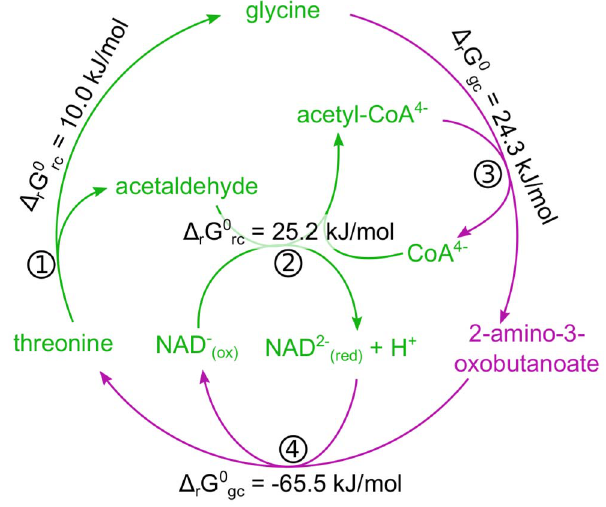
Figure 2. An example of a futile cycle where Gibbs energies are derived using RC and GC. The combined stoichiometry of (1) threonine aldolase, (2) acetaldehyde dehydrogenase (acetylating), (3) glycine C-acetyltransferase, and (4) threonine:NAD oxidoreductase creates a futile cycle where all the inputs and outputs are balanced. Using RC we are able to derive the D r G 0 of reactions 1 and 2 (green), but since 2-amino-3-oxobutanoate does not appear in formation energy tables – we must use GC for reactions 3 and 4 (magenta). The sum of all D r G 0 in this case is 2 6.0 kJ/mol which is a violation of the first law of